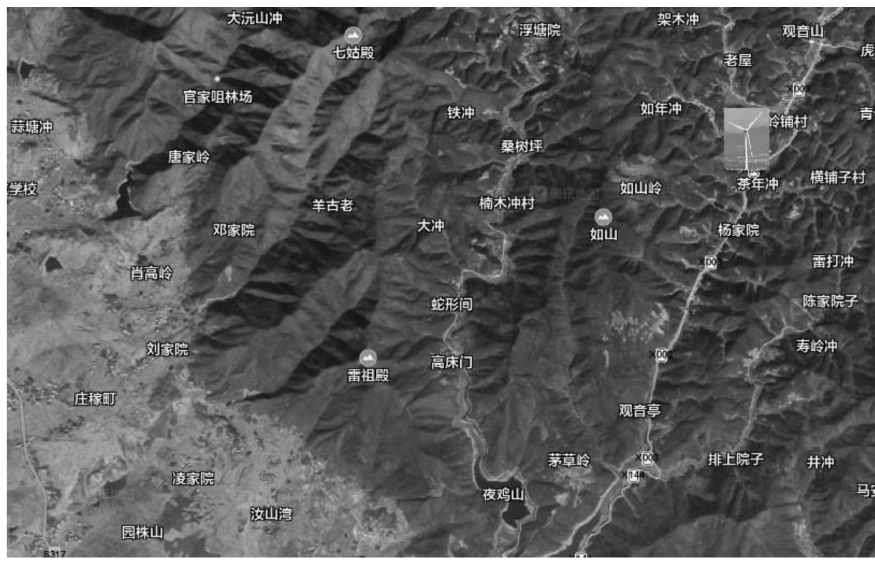
Figure 5. The geographical location of wind farm.